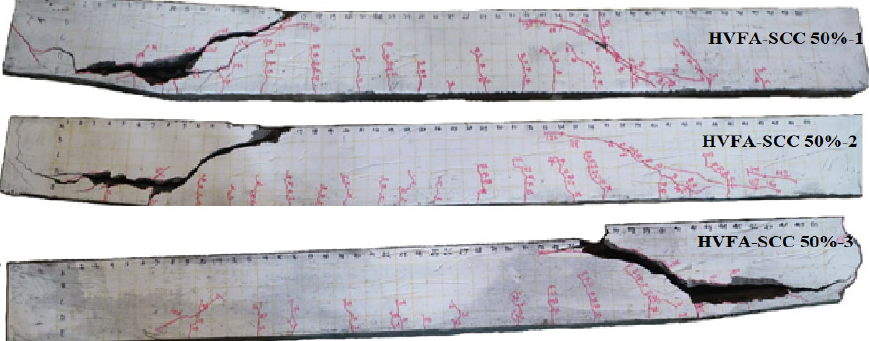
Figure 7. Crack pattern of 50% HVFA ‐ SCC concrete at ultimate shear force.